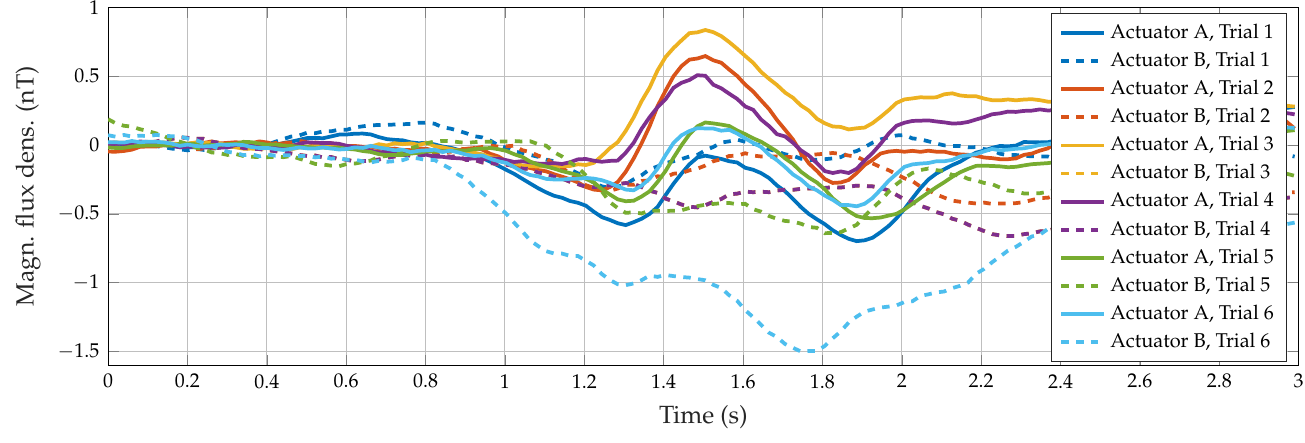
Figure 7. Signals of both actuators for six swallowing attempts with water.